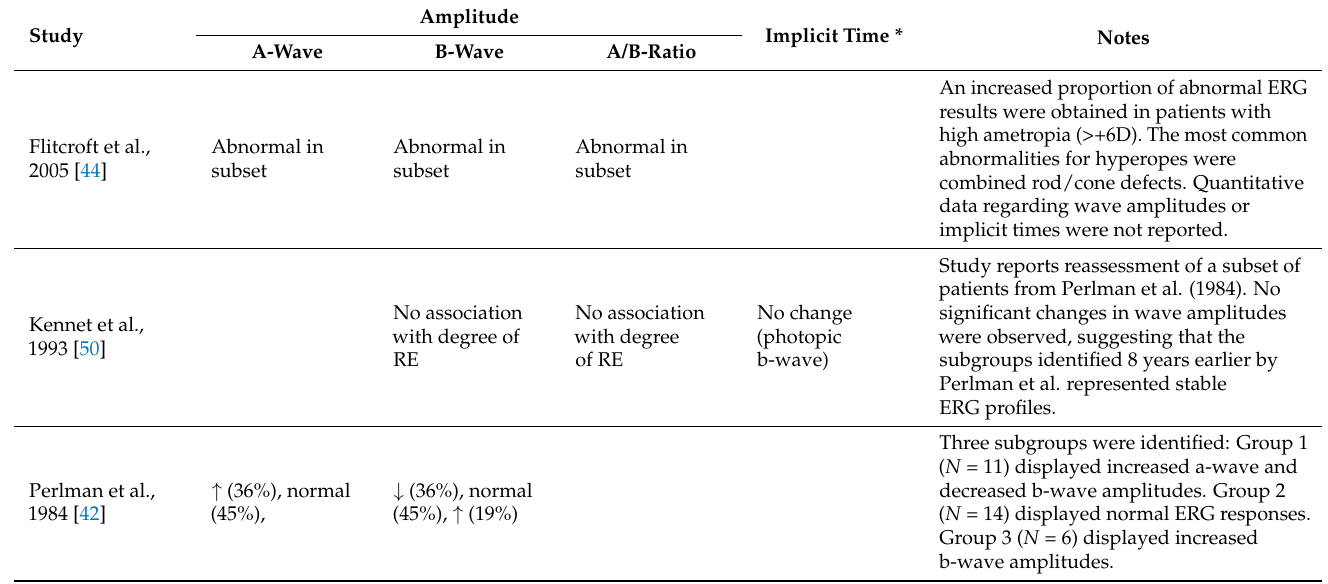
Table 8. ERG Results of Studies Assessing